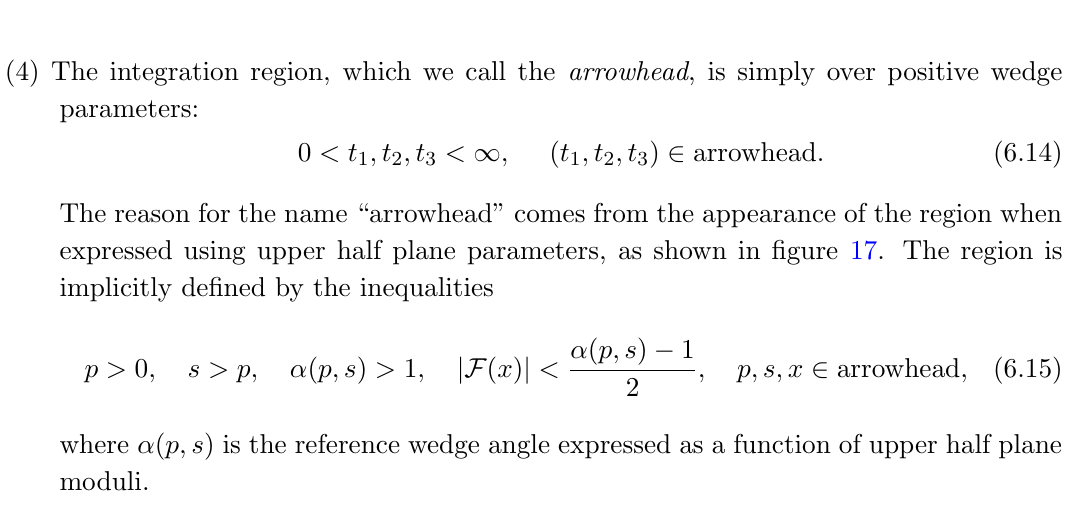
Figure 17 . The \arrowhead" integration region de(cid:12)ning the coe(cid:14)cients of the solution. The (cid:13)ag height is taken here at ‘ = :